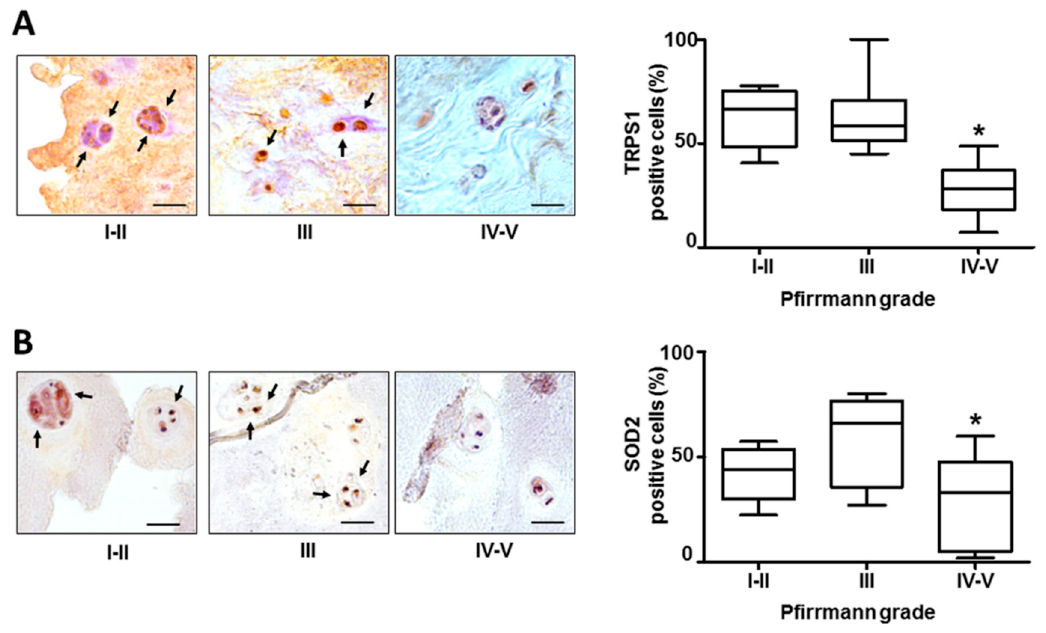
Figure 1. TRPS1 and SOD2 expression in IVD tissues. Immunohistochemistry of TRPS1 ( A ) and SOD2 ( B ) was performed on IVD tissues with different Pfirrmann grades of degeneration. Positive cells in representative optical photomicrographs are indicated with arrows. Protein levels were quantified by densitometric analysis of immunostaining using ImageJ software and expressed as % of positive cells per area (five sections per sample; Pfirrmann I–II group, n = 8; Pfirrmann III group, n = 9 and Pfirrmann IV–V group, n = 13). The results are reported as a whisker box plot representing the min to max (line indicates median). * = p < 0.01 (Pfirrmann IV–V group vs. Pfirrmann I–II group and Pfirrmann III group). Scale bars: 20 µm.